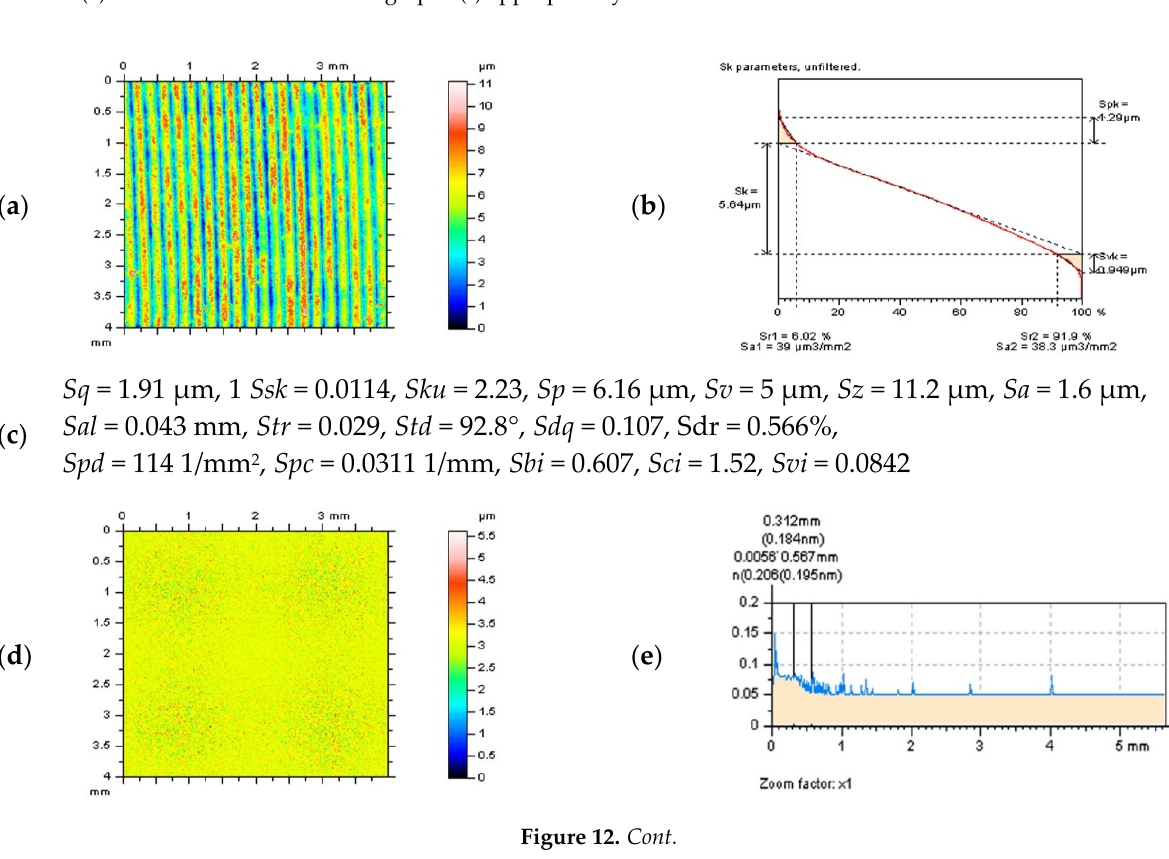
( i ) Figure 12. Contour map plot of the milled surface after a high-frequency errors reduction by a DMF method ( a ) with material ratio curve ( b ) and selected surface topography parameters ( c ) correspondingly, the S-surface received by appli- cation of DMF approach with cut-off = 0.025 mm ( d ), its PSD ( e ) and ACF ( f ), results of thresholding (0.13–99.87%) of S- surface ( g ) and ACF ( h ), the texture direction graph ( i ) defined for thresholded S-surface presented in ( g ) subsection of the figure.